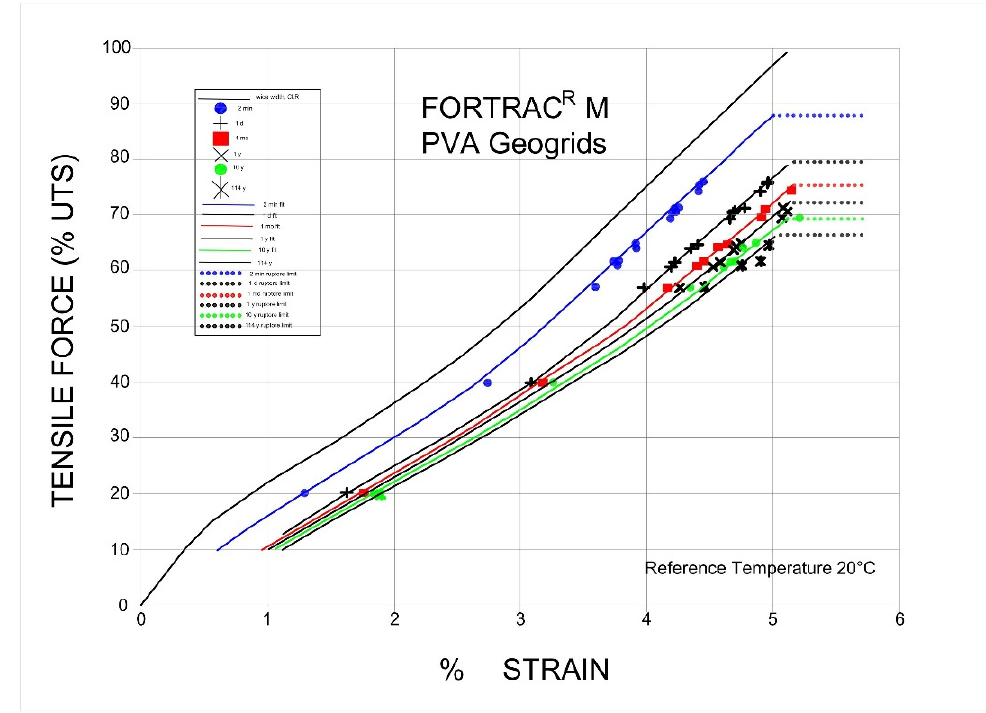
Figure 1. Example isochrones of PVA geogrids. Adapted from [38].